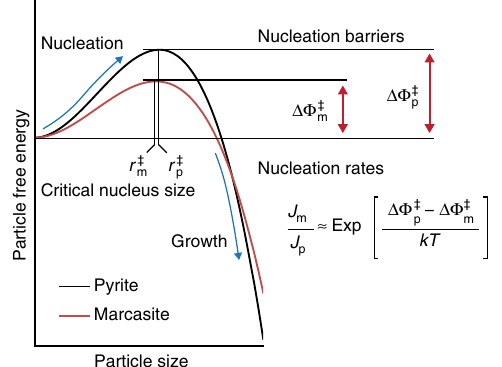
Figure 3 | Relationship between finite-size energetics and nucleation kinetics. A schematic illustration of nucleation kinetics leading to the formation of metastable marcasite due to a lower kinetic barrier to nucleation DF z and a correspondingly exponentially higher nucleation rate m J m , relative to that of pyrite ( DF z and J p , respectively) 8 p